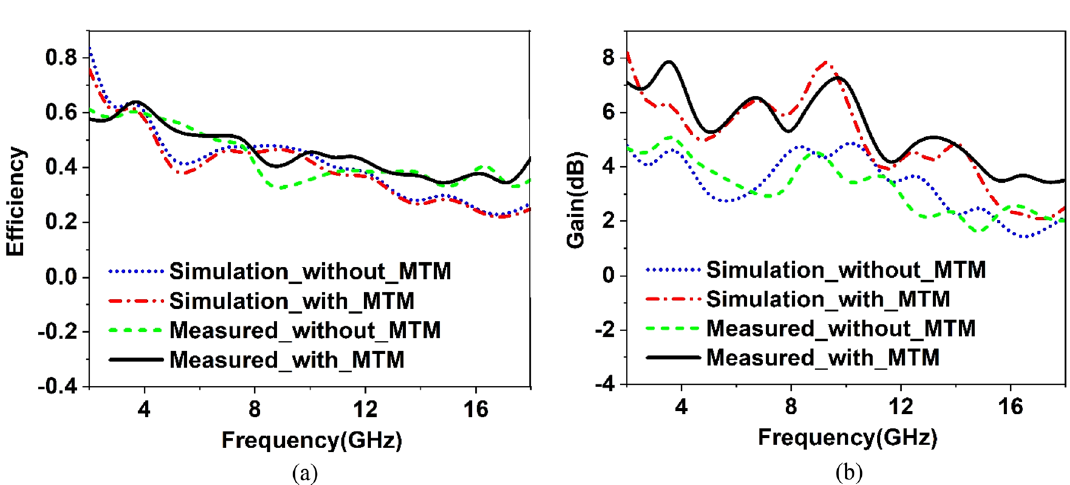
Figure 38. Comparison of simulated and measured results of the proposed antenna with and without metamaterial cover: ( a ) Efficiency ( b )